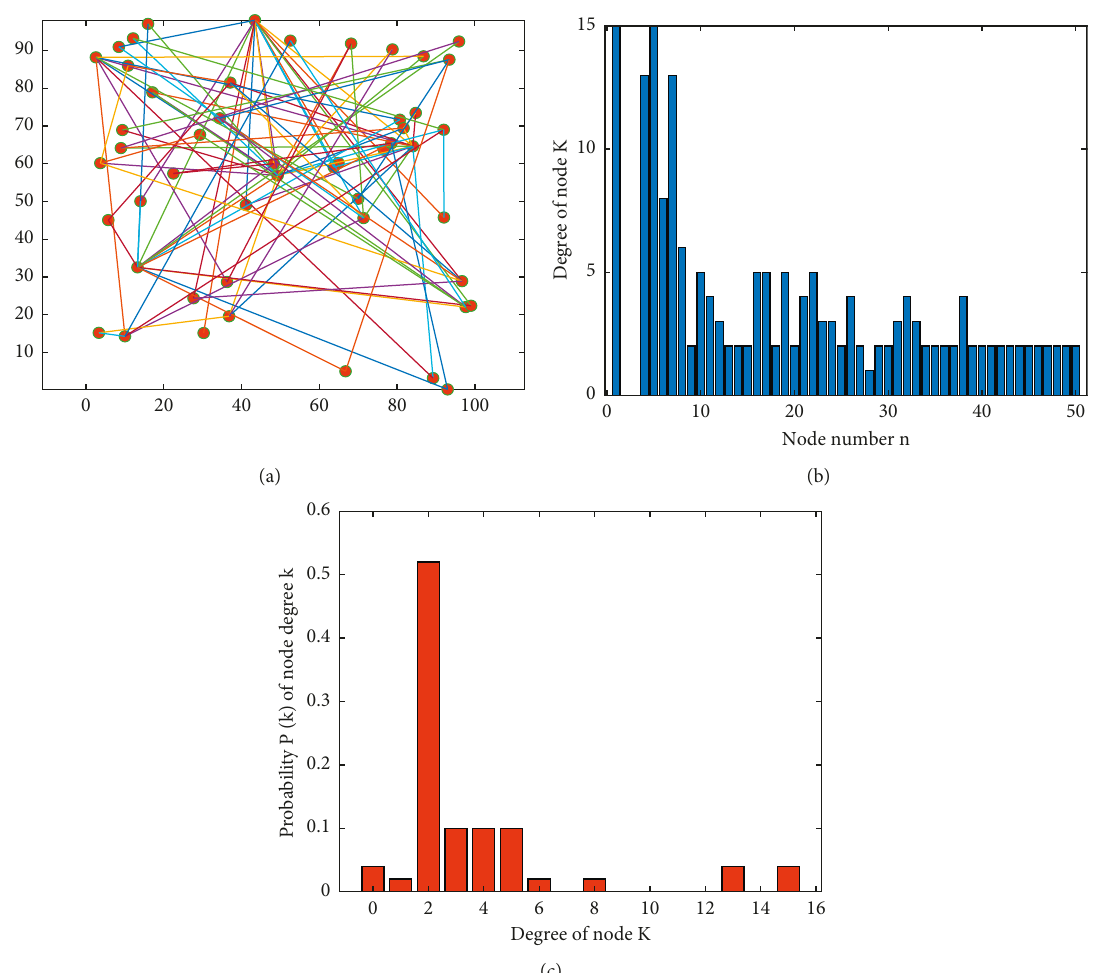
Figure 1: Scale-free network and related statistics. (a) Scale-free network topology. (b) Distribution diagram of node degree. (c) Probability distribution of node degree in the